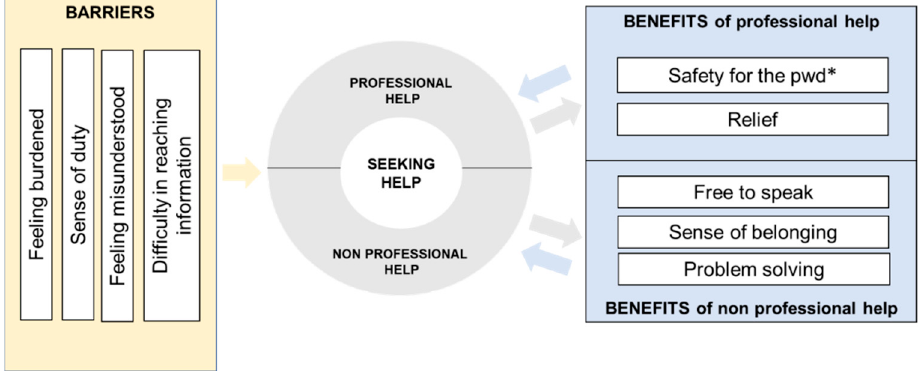
Figure 1. The virtuous cycle of seeking help. * person with dementia.